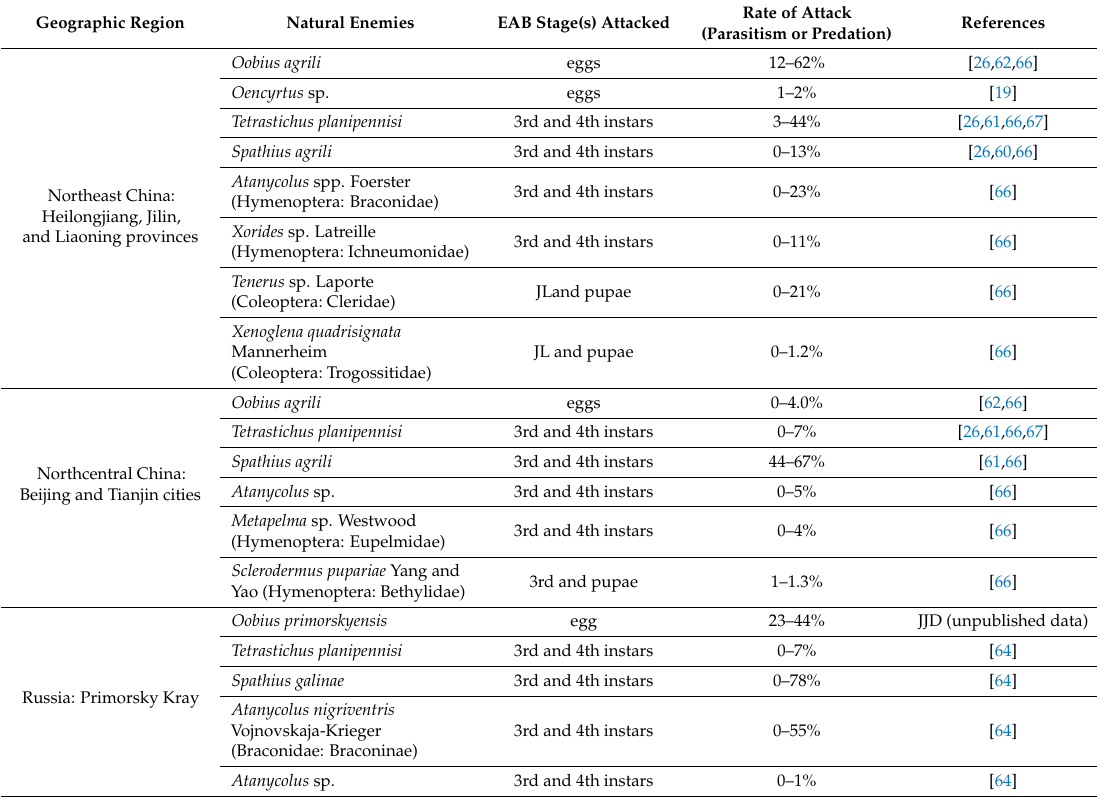
Table 1. Natural enemy complexes and their observed attack rates on the emerald ash borer (EAB) in different regions of its native range in northeastern